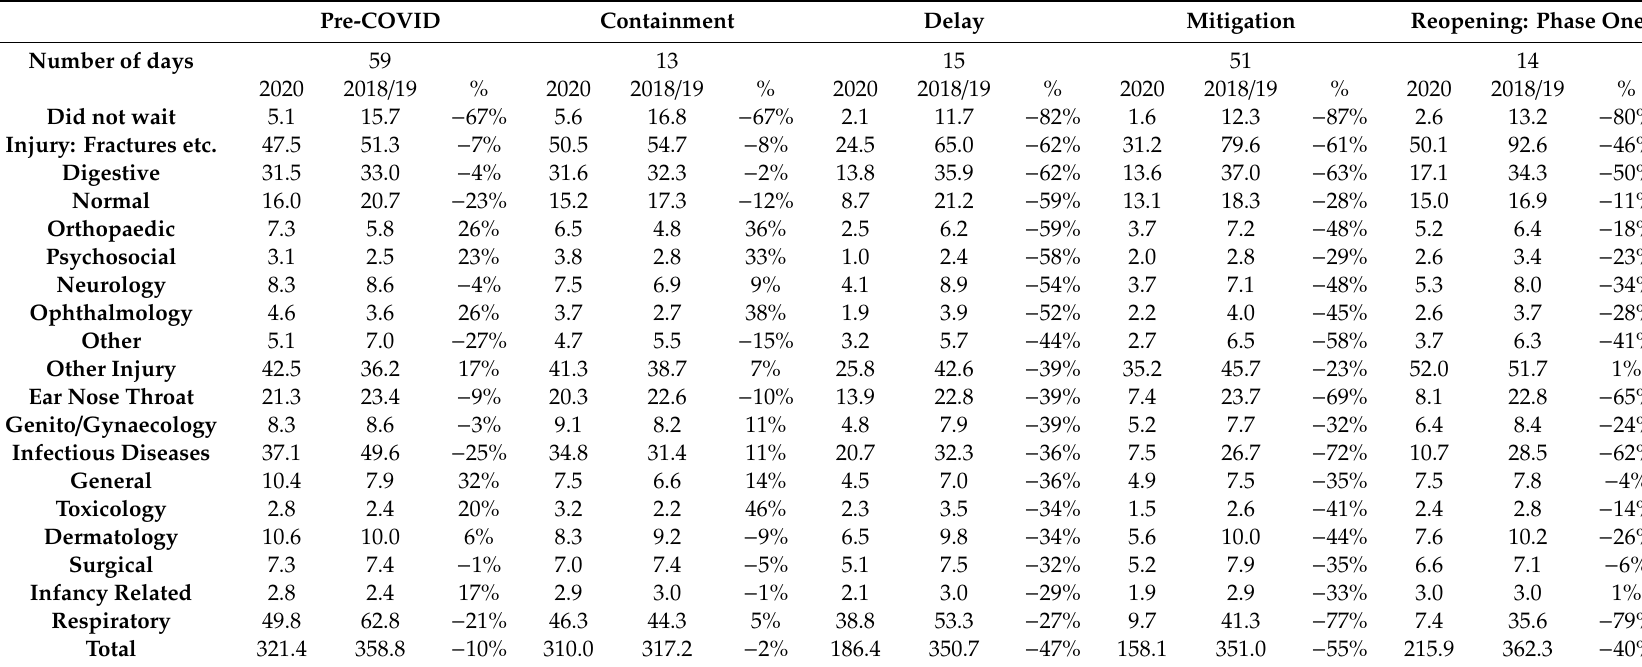
Table A1. Mean daily paediatric emergency department attendance, by category, by public health COVID-19 response stage: Dublin only.